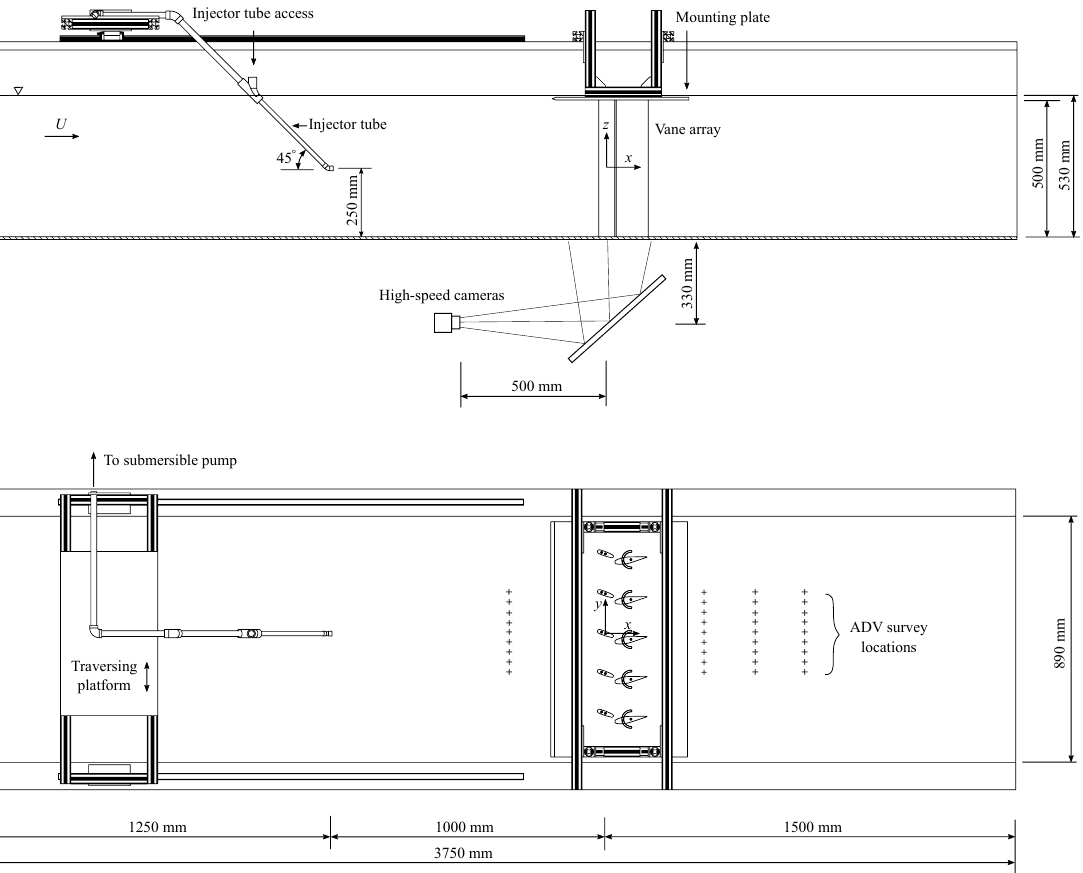
Figure 2. Schematic of test section of recirculating water flume showing bead injector tube and vane array